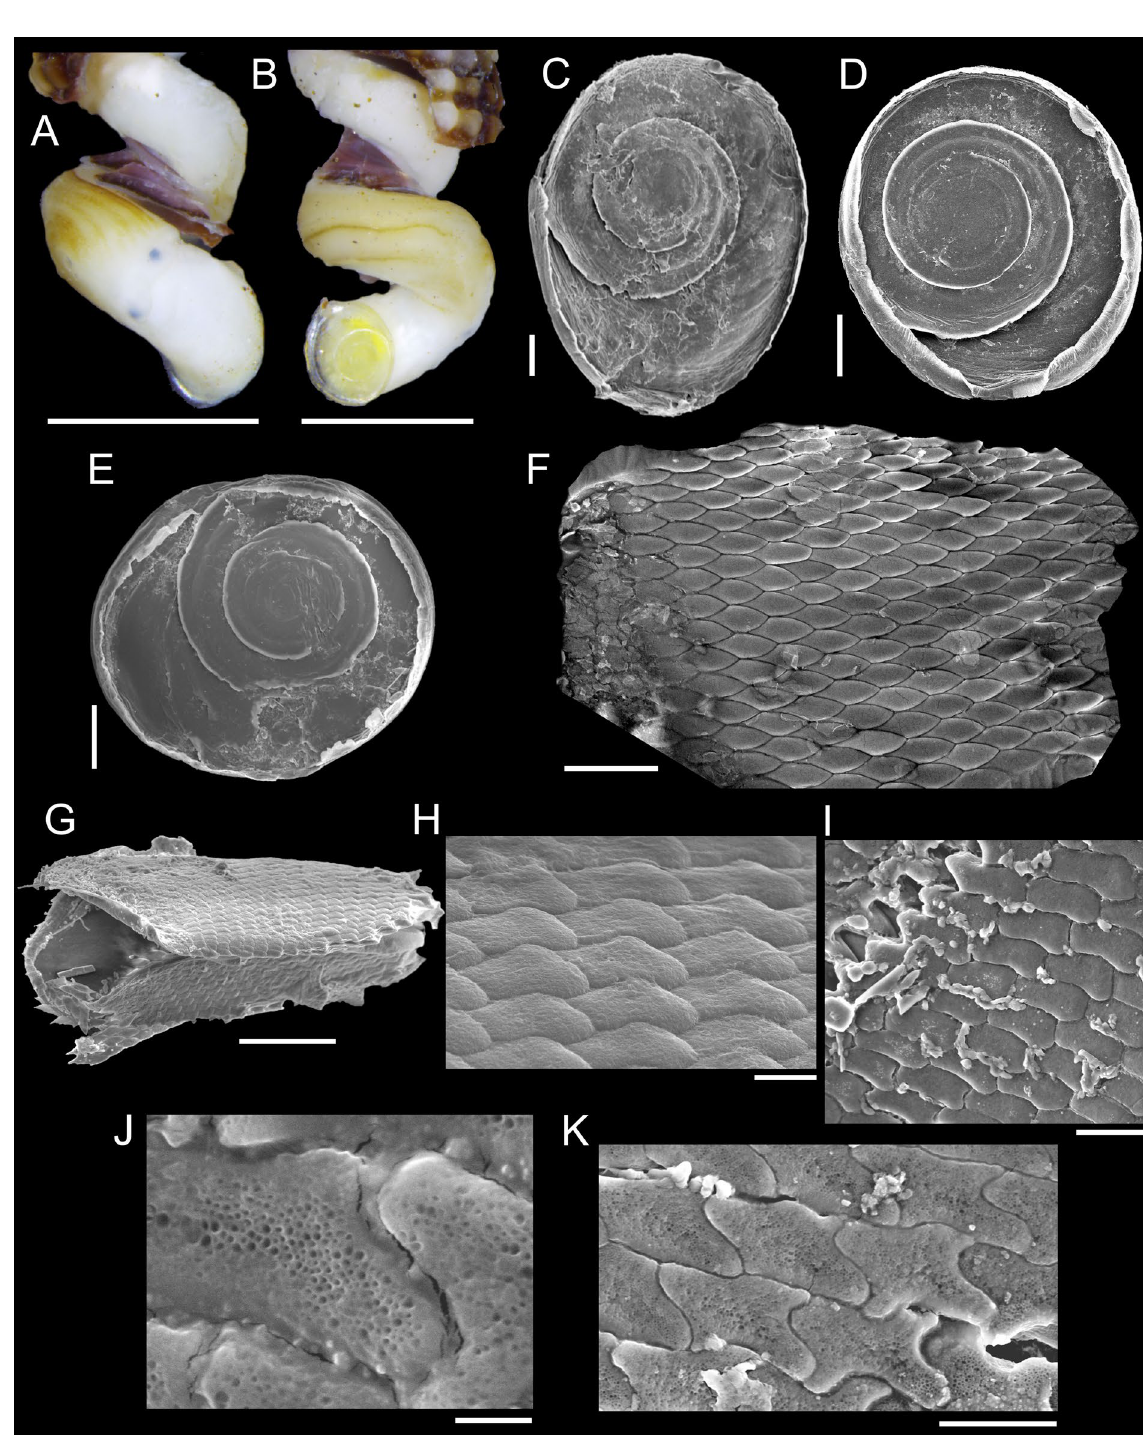
Fig. 21. Nototriphora decorata (C.B. Adams, 1850). A–B . MNRJ 28941. C . MNRJ 19785. D–E . MNRJ 32763. F, I–K . MNRJ 28854. G–H . ZUEC-GAS 1804. A–B . External morphology. C–E . Operculum. F–K . Jaw, inner ( F ) and outer ( G–K ) sides. Scale bars: A–B = 1 mm; C–E = 100 µm; F = 20 µm; G = 50 µm; H = 5 µm; I, K = 10 µm; J = 2